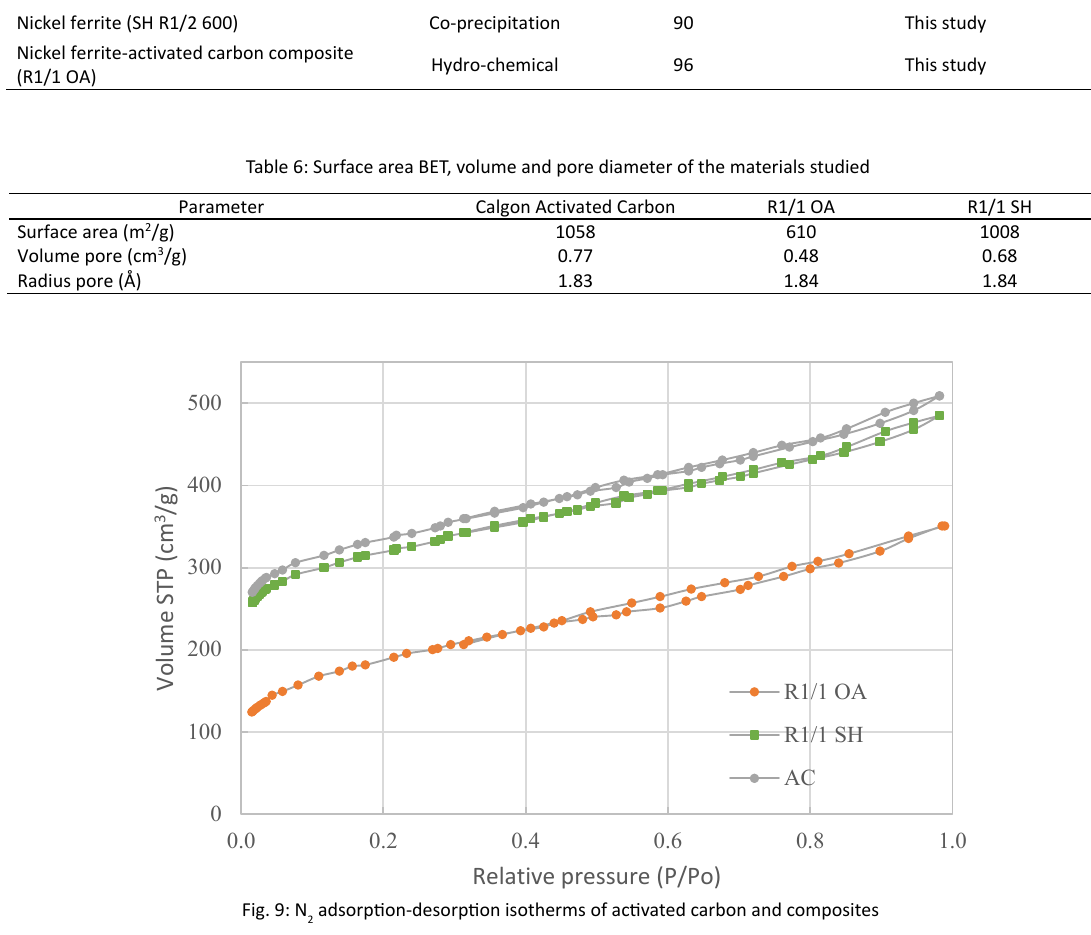
Fig. 9: N 2 adsorption-desorption isotherms of activated carbon and composites